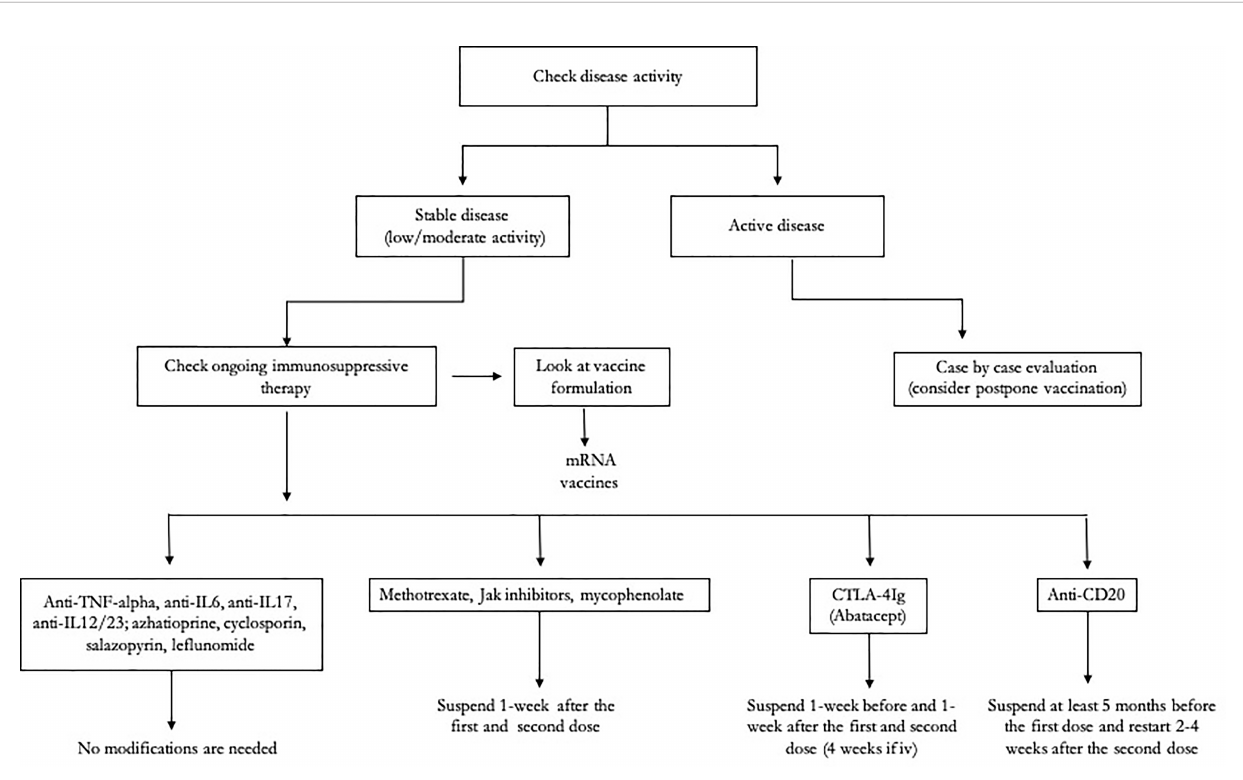
FIGURE 1 | Clinical algorithm for the management of patients with autoimmune rheumatic diseases (ARDs) undergoing severe acute respiratory syndrome coronavirus-2 (SARS-CoV-2)